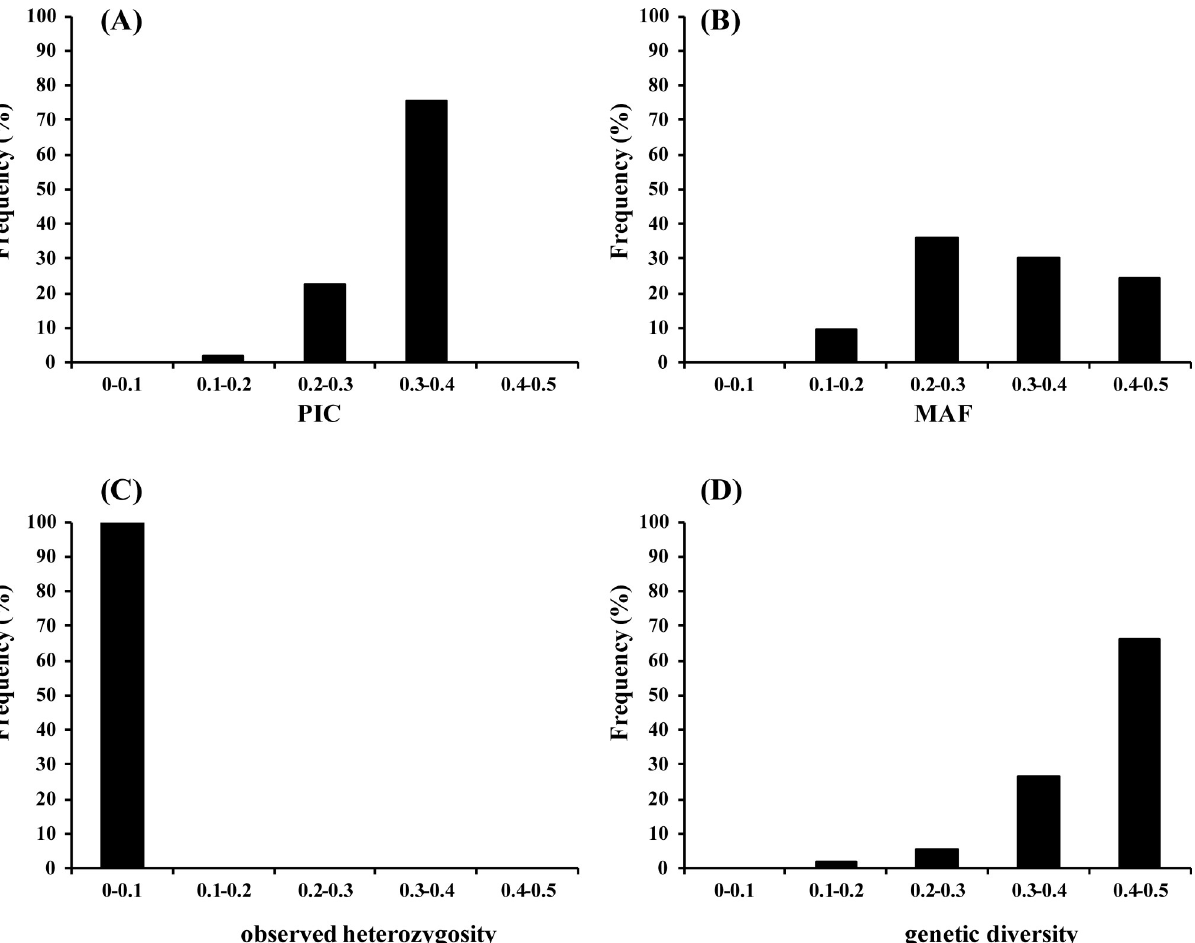
Fig 5. PIC (A), MAF (B), observed heterozygosity (C) and genetic diversity (D) values for the 53 KASP-SNP markers based on data from 34 accessions.